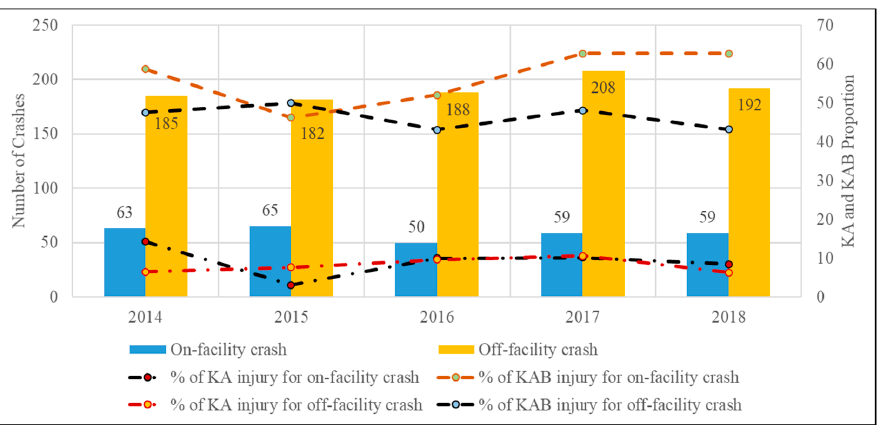
Figure 6. Annual frequencies and proportions of KA and KAB bicycle crashes based on presence of